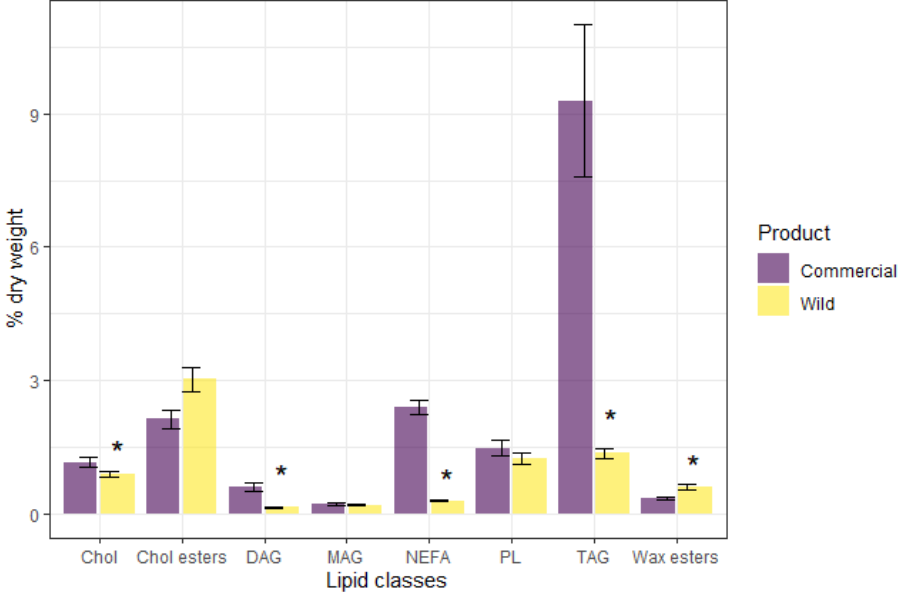
Figure 4. The content of individual lipid classes in muscle tissue from the wild and commercial beaked redfish Sebastes mentella samples. Note: *—significantly ( p ≤ 0.05) different between wild and commercial product.